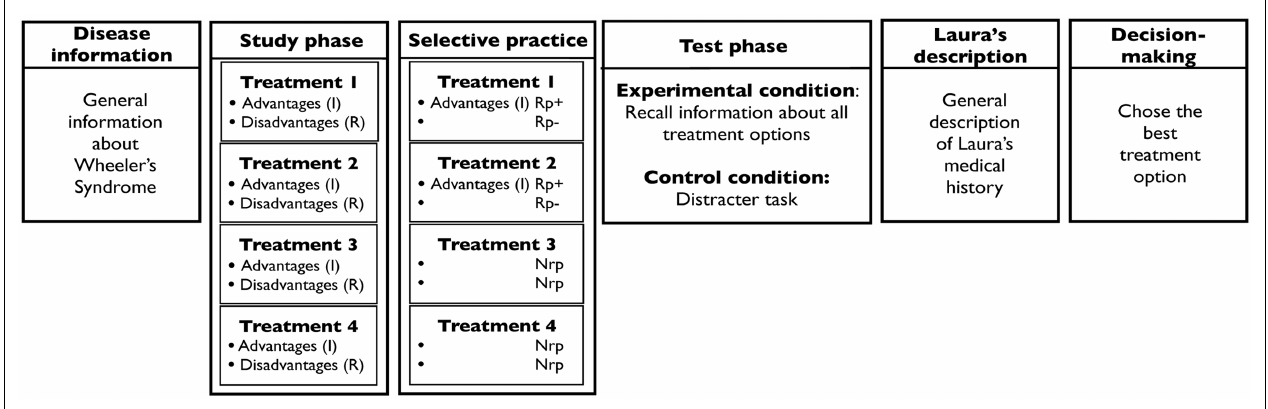
Valence condition, participants studied irrelevant disadvantages (the negatively stated version of irrelevant advantages) and relevant advantages (the positively stated version of relevant disadvantages) for each treatment, and selectively practiced irrelevant disadvantages for two of the four